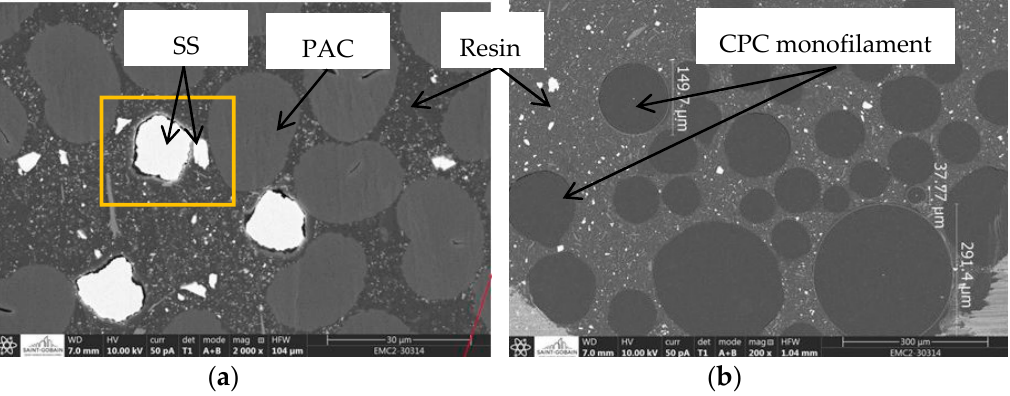
Figure 6. Morphology of the conductive yarns with the resin: ( a ) SS20/PAC80 (the resin compression of the stainless steel (SS) and the polyacrylate (PAC) fibres) and ( b ) PA12 + 3%CNT + 14%CB (separation of the multifilaments by the resin).